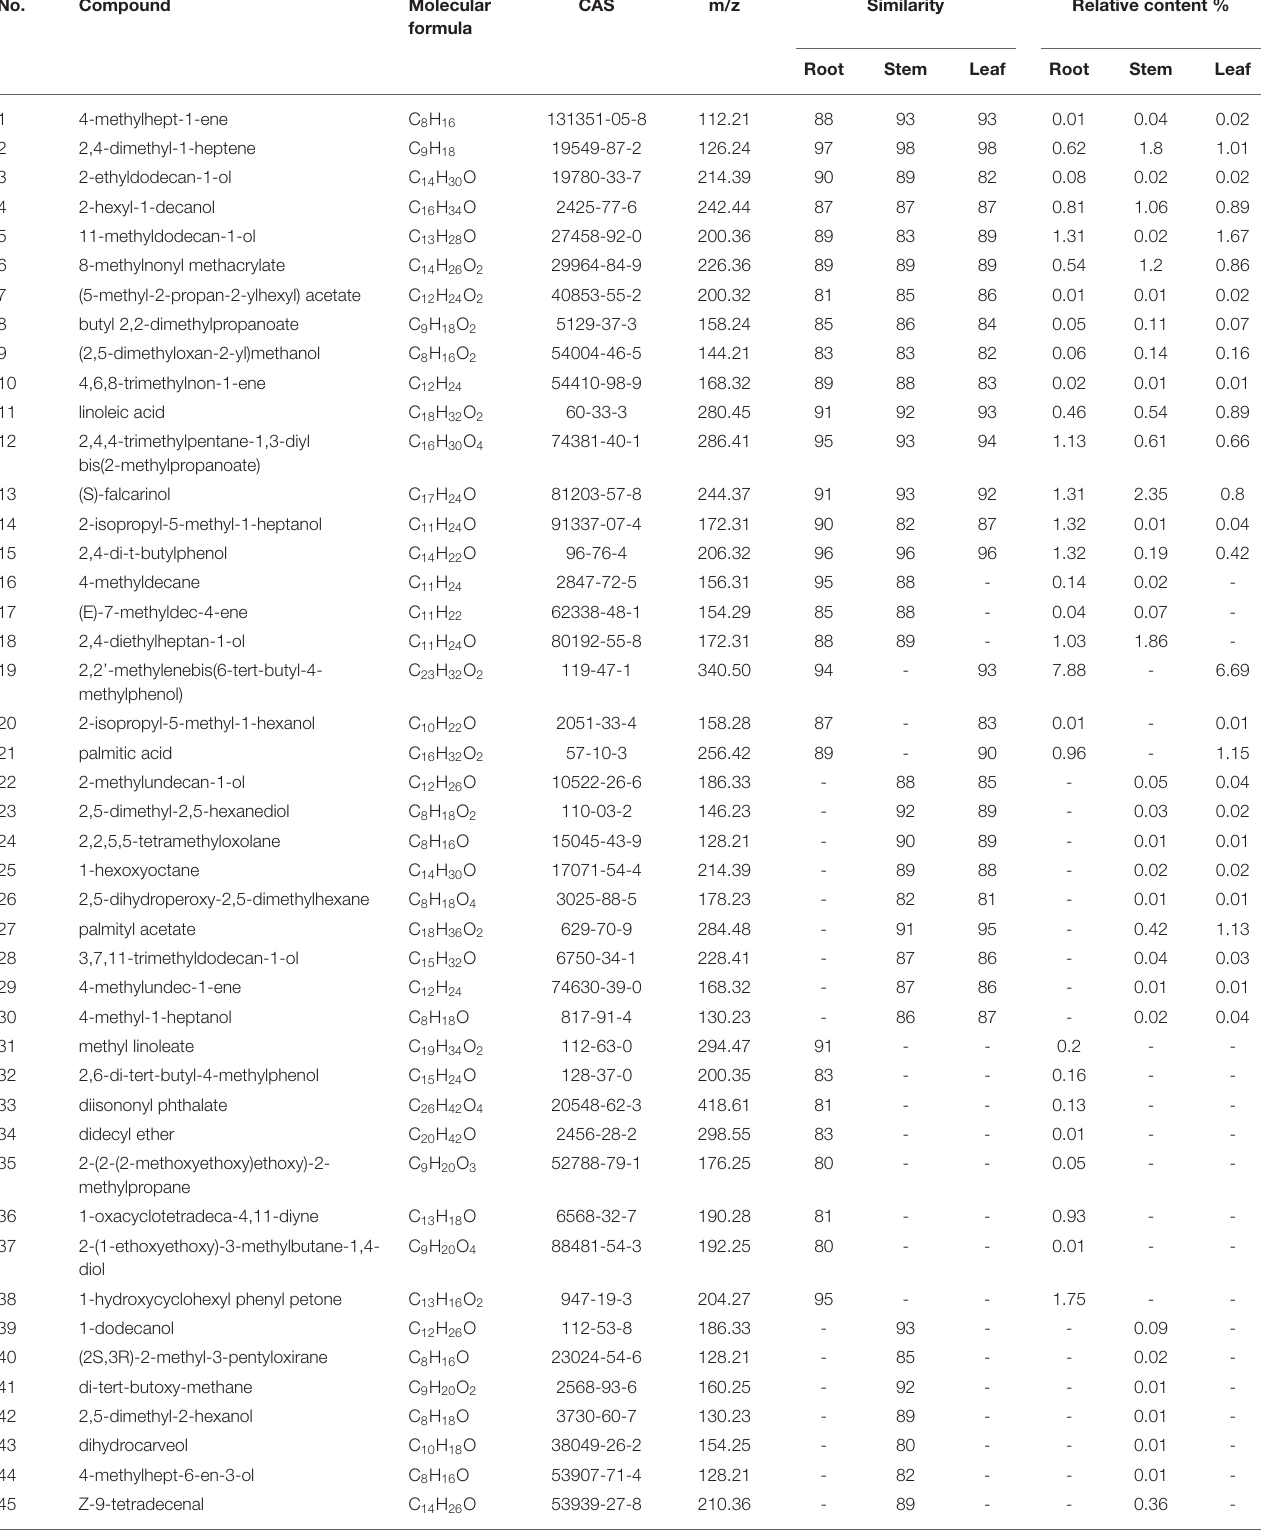
TABLE 3 | Volatile constituents in root, stem and leaf of P. notoginseng .